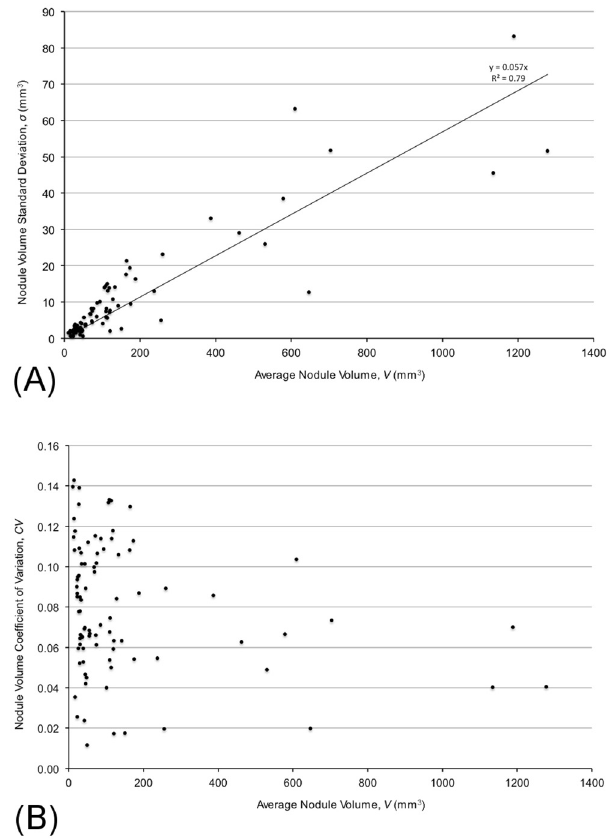
Fig 3. Error in nodule volume determination. (A) Plot of nodule volume standard deviation σ V versus mean nodule volume (cid:1) V (mm 3 ) for all datasets. Linear regression for our non-calci fi ed nodules (solid line) gives, ¼ 0 : 057(cid:1) V ( a = 0.057 ± 0.002), r 2 = 0.860, p = < 0.001). The dotted line shows the same analysis applied s V to Gietema single-repeat data s V ¼ 0 : 054(cid:1) V ( a = 0.054 ± 0.003), r 2 = 0.590, p = < 0.001). (B) Coef fi cient of Variation for all nodules. Above 100 mm 3 , CV is below